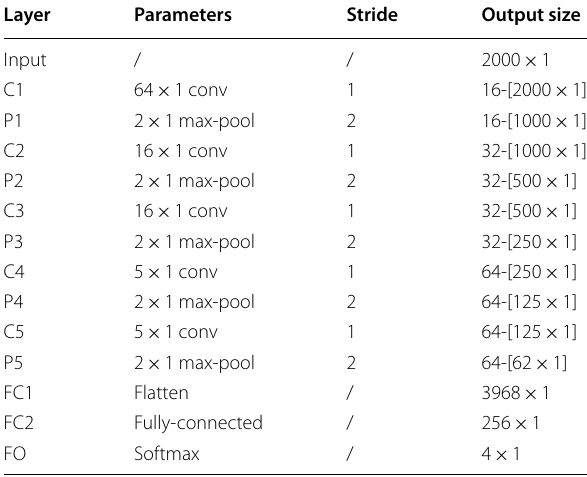
Table 3 Architecture of the 1-D CNN